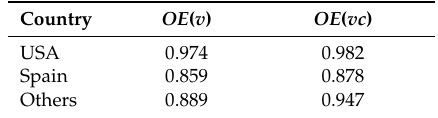
Table 10. Average output-based e ffi ciencies: three country